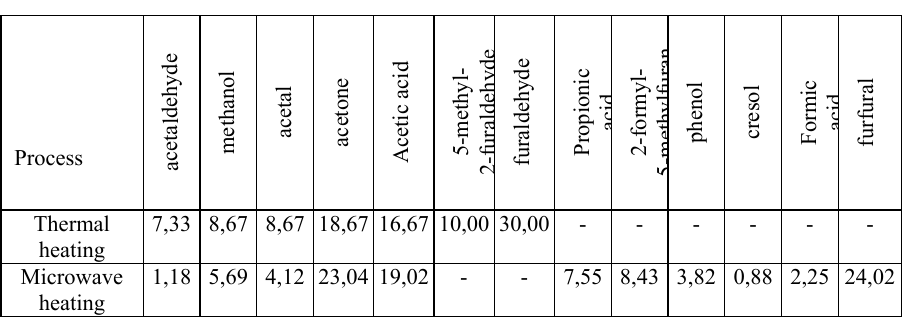
Table 2. Chromatography-mass spectrometry analysis of oily